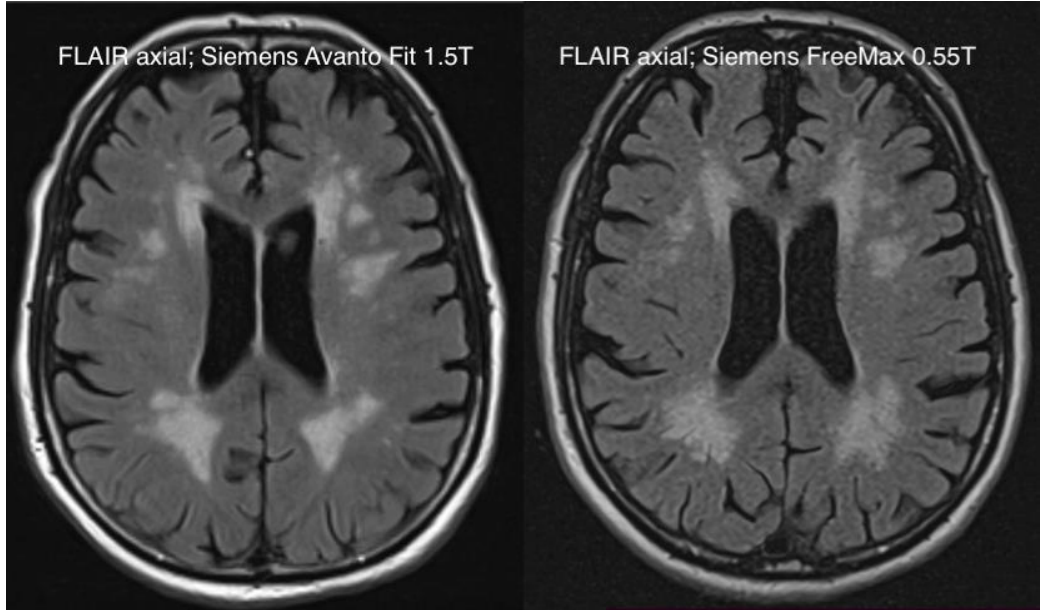
Figure 6. Exemplary comparison of an axial FLAIR sequence in the context of brain imaging with the Siemens Avanto FIT 1.5T (left side) and the Siemens Free Max 0.55T (right side).